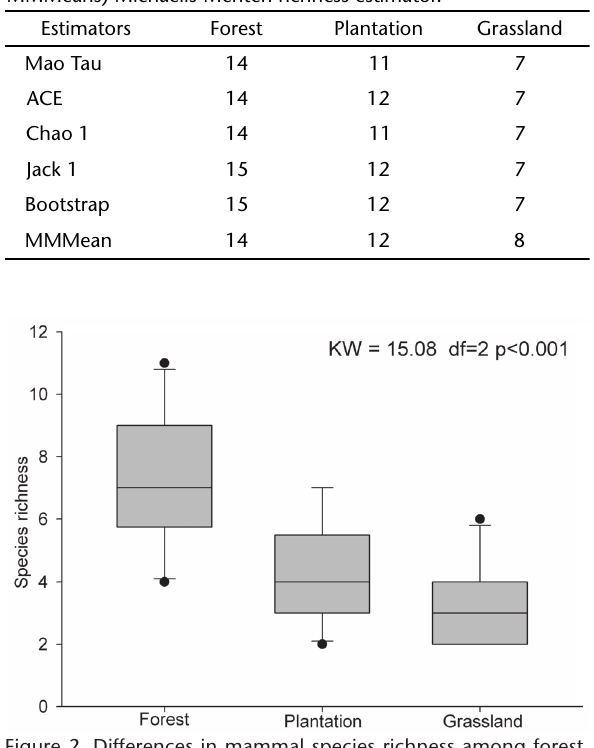
Figure 2. Differences in mammal species richness among forest, grassland and plantation sites.